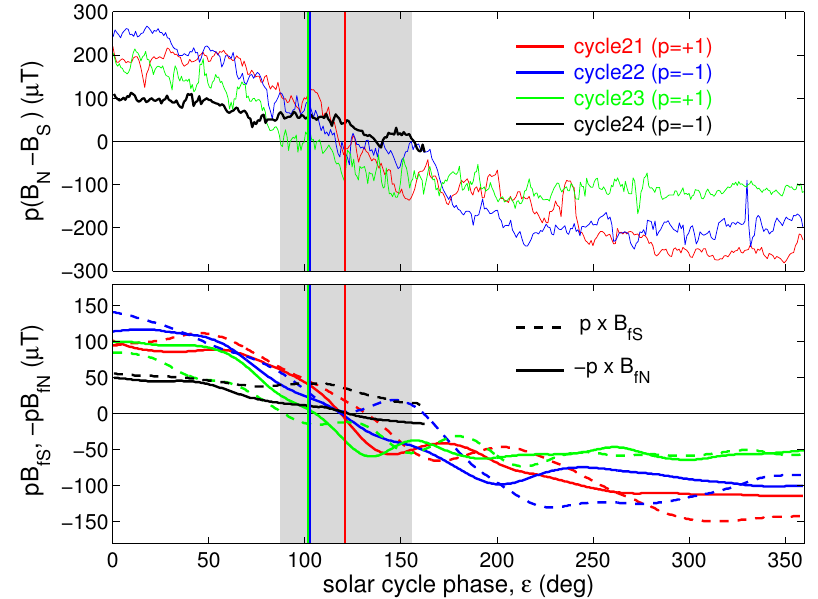
Figure 41: Update of the solar polar field plot given in Figure 39. Plot updated on 1 August 2013.